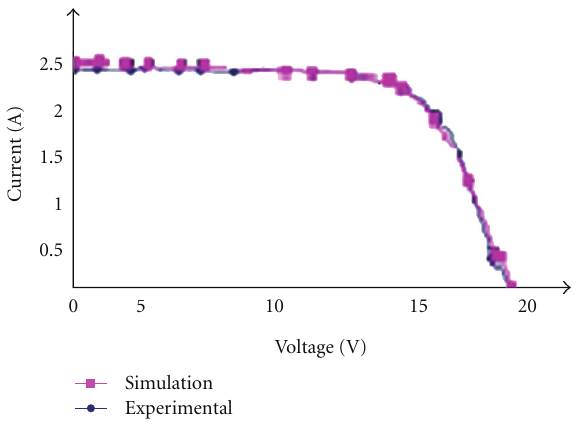
Figure 10: Simulation and experimental V-I characteristics.